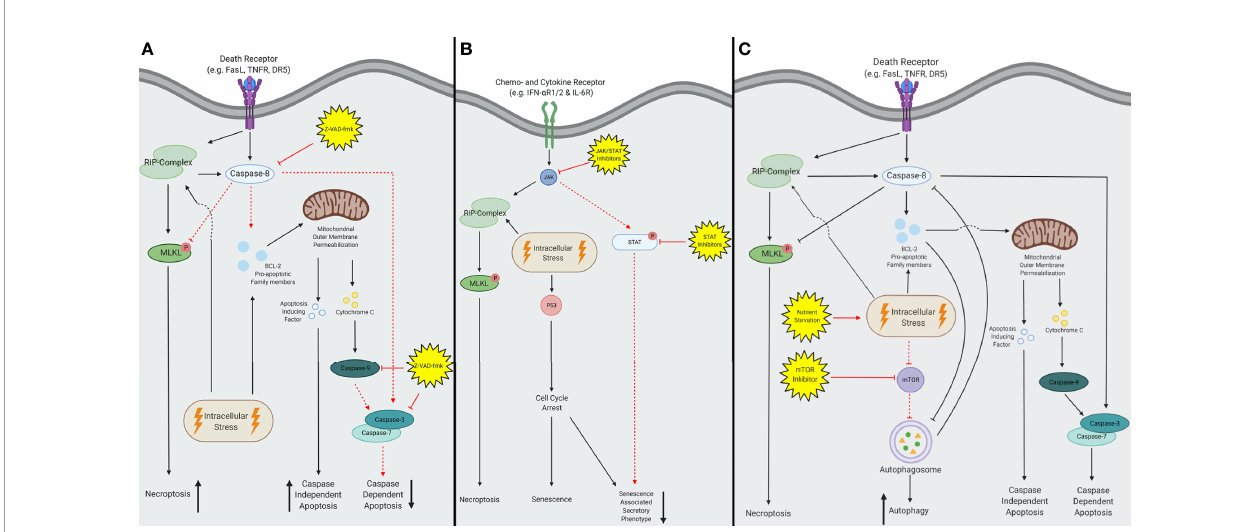
FIGURE 3 | A schematic overview of inhibitors converting tolerogenic cell death to immunogenic cell death. (A) The pan-caspase inhibitor Z-VAD-fmk inhibits all caspase activity, the subsequent effects are depicted with red dotted lines. Z-VAD-fmk forces extrinsic stimuli to activate the RIP-kinase complex and thereby initiates necroptosis instead of caspase-dependent apoptosis. Intrinsic stimuli remain able to activate the pro-apoptotic BCL-2 family members and subsequently facilitate mitochondrial outer membrane permeabilization (MOMP). Consequently, both apoptosis inducing factors (AIF) and cytochrome C are released, but only AIF is able to induce apoptosis. Therefore, caspase-dependent apoptosis will be inhibited and decreased, and caspase-independent apoptosis will increase. (B) Both Janus kinase- signal transducer and activator of transcription (JAK-STAT) and JAK inhibitors are capable of inhibiting the senescent pathway, depicted in red dotted lines. This reduces the activation of the senescent associated secretory phenotype (SASP) after activation of the extrinsic pathway. In contrast, the intrinsic pathway remains able to induce the SASP via activation of p53. (C) Both nutrient starvation and mammalian target of rapamycin (mTOR) inhibition increase autophagy, by upregulation of the autophagosome. This fi gure was created by authors using Biorender tools